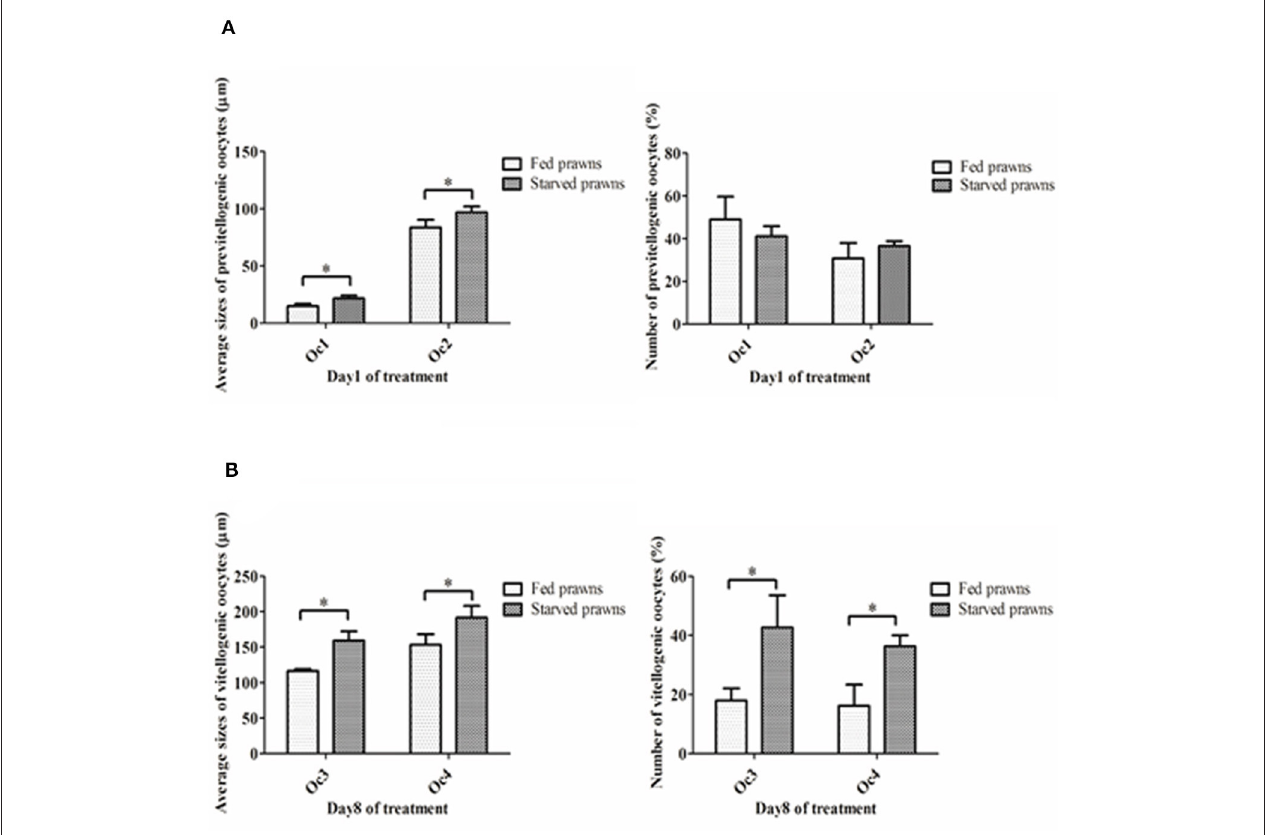
FIGURE 3 | (A) Mean oocyte diameters and numbers of pre-vitellogenic oocytes (Oc1, Oc2) of the starved prawns at day1 compared to that of the fed prawns. (B) Mean oocyte diameters and numbers of vitellogenic oocytes (Oc3 and Oc4) of the starved prawns at day 8 compared to that of the fed prawns. Asterisks indicate significant differences compared to the fed group with p < 0.05. ( n = 50 randomly selected oocytes per ovary).